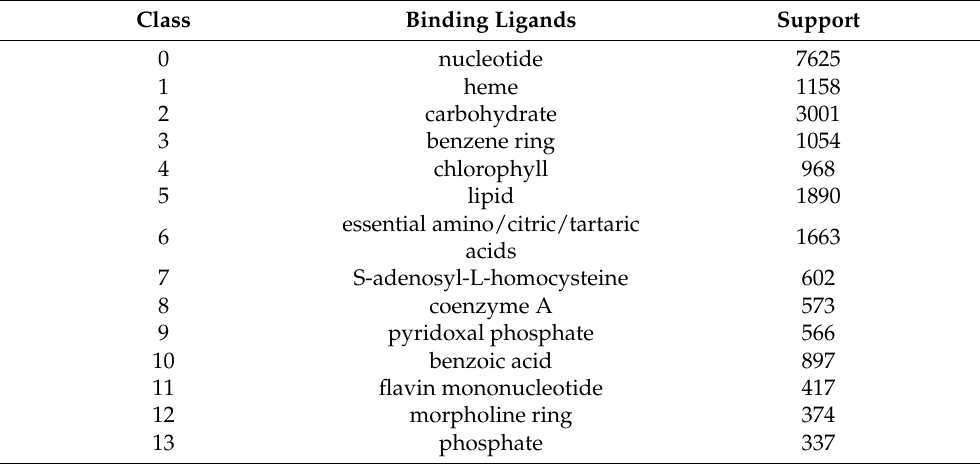
Table 1. Classes of ligand binding sites in the primary benchmarking dataset. Support is the number of pockets in the